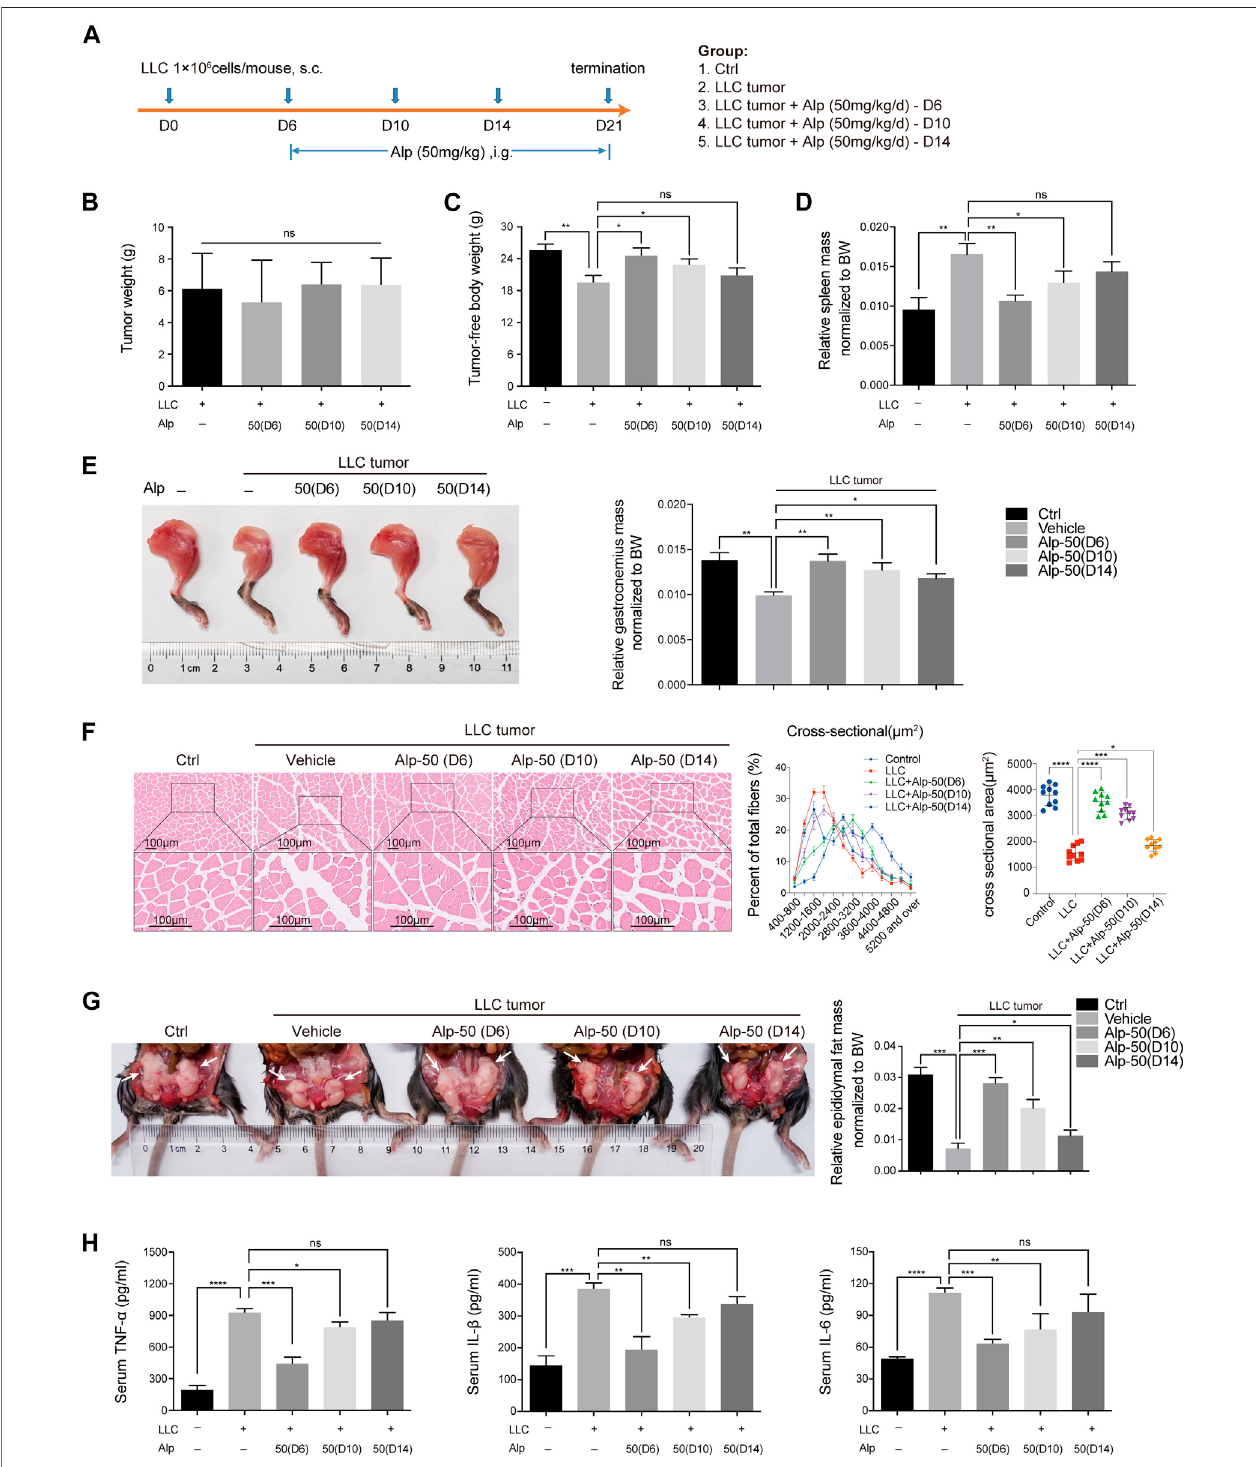
FIGURE 6 | Effects of delayed administration with Alp until advanced stages of tumor and cachexia progression in LLC tumor – bearing mice. (A) Schematic presentation of the experimental design. The delayed treatment role of Alp in (B) tumor weight, (C) tumor-free body weight, (D) spleen mass, (E) gastrocnemius muscle mass, and (G) epididymal fat mass of cachexia mice were explored (BW: body weight). (F) Gastrocnemius muscle wasting was presented by HE staining and cross- sectional area analysis. (H) Pro-in fl ammatory cytokines of TNF- α , IL-1 β , and IL-6 were analyzed by ELISA in the serum of cachexia mice. * p < 0.05, ** p < 0.01, *** p < 0.001, **** p < 0.0001 vs. control. ns: not signi fi cant. n (cid:1) 10 mice/group.